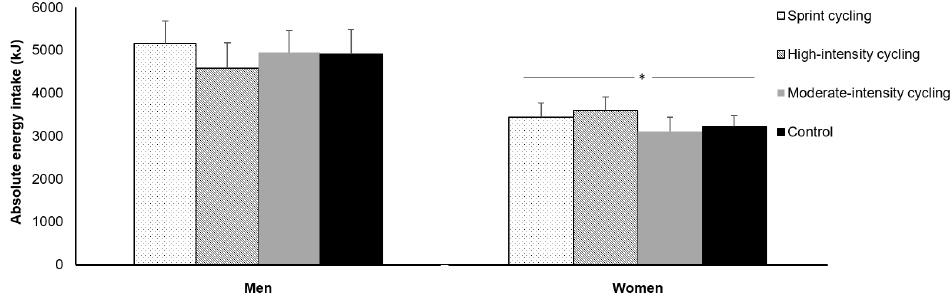
Figure 2. Absolute energy intake at an ad libitum buffet meal in the control, moderate-intensity, high-intensity intermittent and sprint interval cycling trials in 11 men and nine women. Data are mean ± SEM. * Significant difference between men and women. Data from Panissa et al. [87]. © RightsLink. Reproduced with permission.